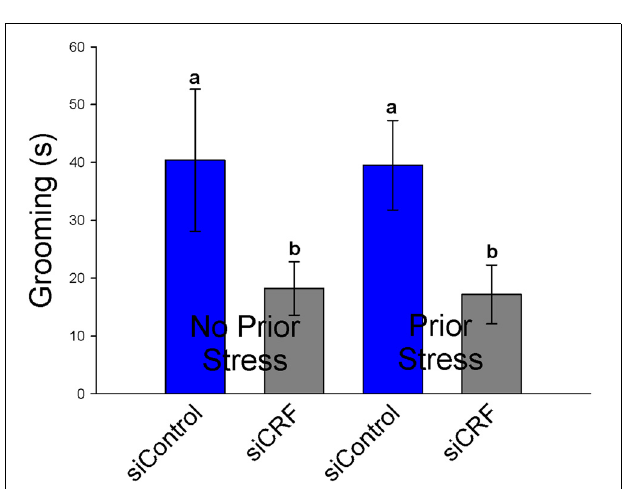
FIGURE 8 | Grooming Behavior on the EPM (s ± SEM) was significantly attenuated in rats with decreased CRF in CeA ( p < 0 . 05). Prior restraint stress had no effect on this